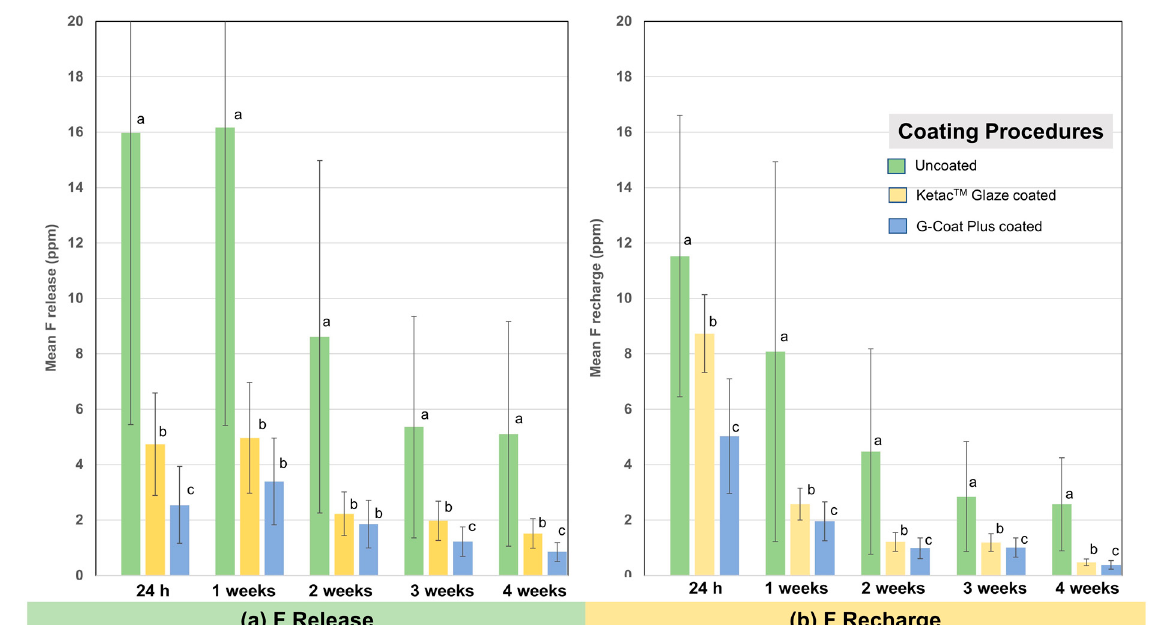
Ketac TM Molar Applicap TM , and Ketac TM Fill Plus Applicap TM ) at 24 h and at 1, 2, 3, and 4 weeks of ( a ) fluoride release and ( b ) fluoride recharge. The different letters on each bar represent statistically significant differences ( p < 0.05) within each time point.